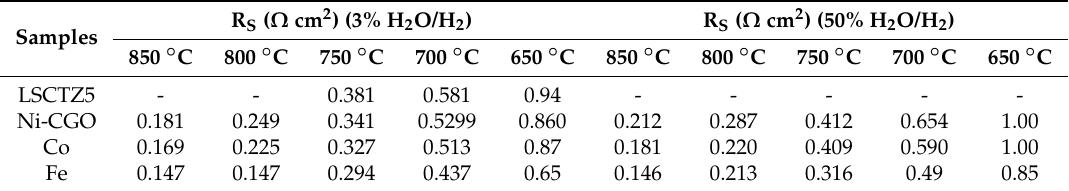
Table 2. Ohmic resistances of LSCTZ5 backbone and infiltrated anodes. Samples